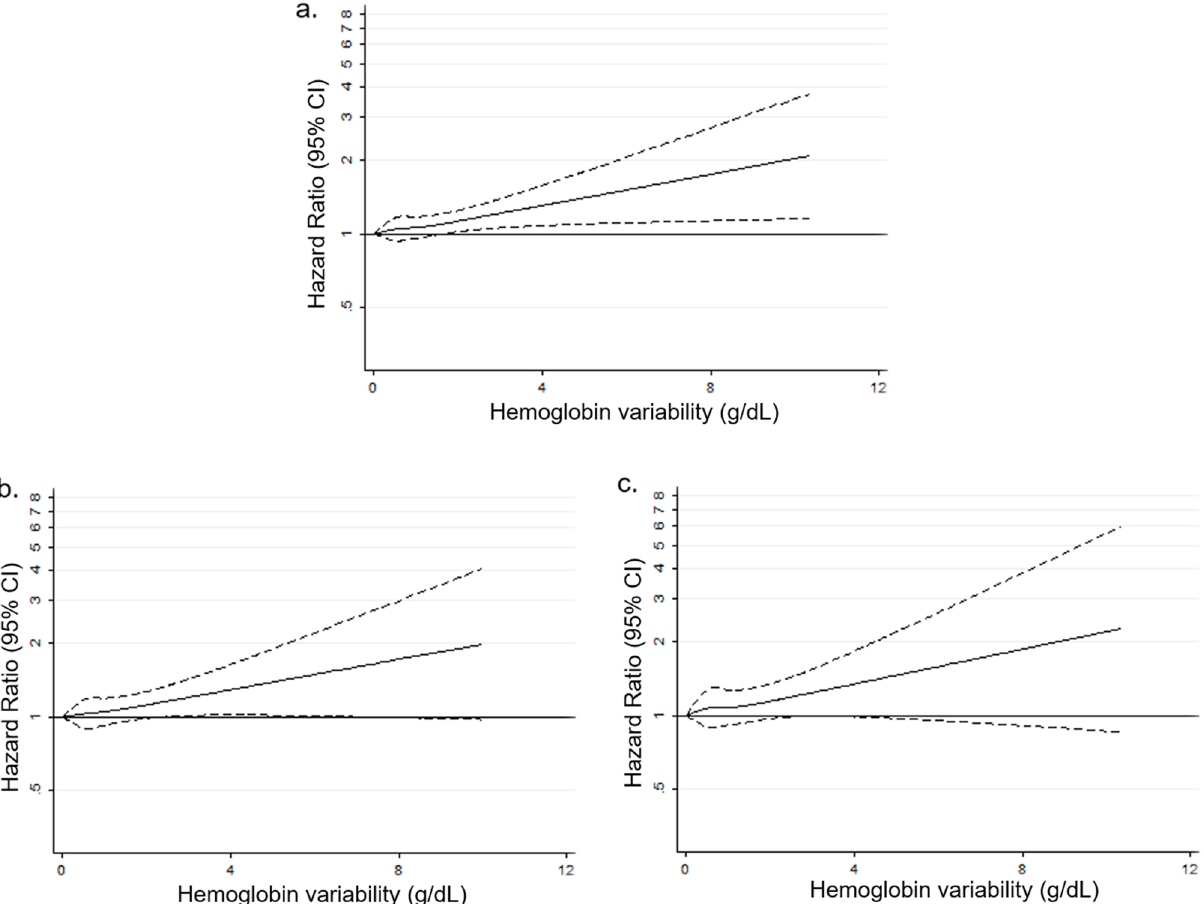
Figure 2. Restricted cubic spline graph of hazard ratio for cardiovascular disease in total cohort ( a ), men ( b ) and women ( c ). Hazard ratio is calculated by Cox proportional hazards regression analysis after adjustments for age, sex, initial hemoglobin level, change in hemoglobin level, household income, smoking, alcohol consumption, physical activity, systolic blood pressure, fasting serum glucose, total cholesterol, and Charlson comorbidity index. CI confidence